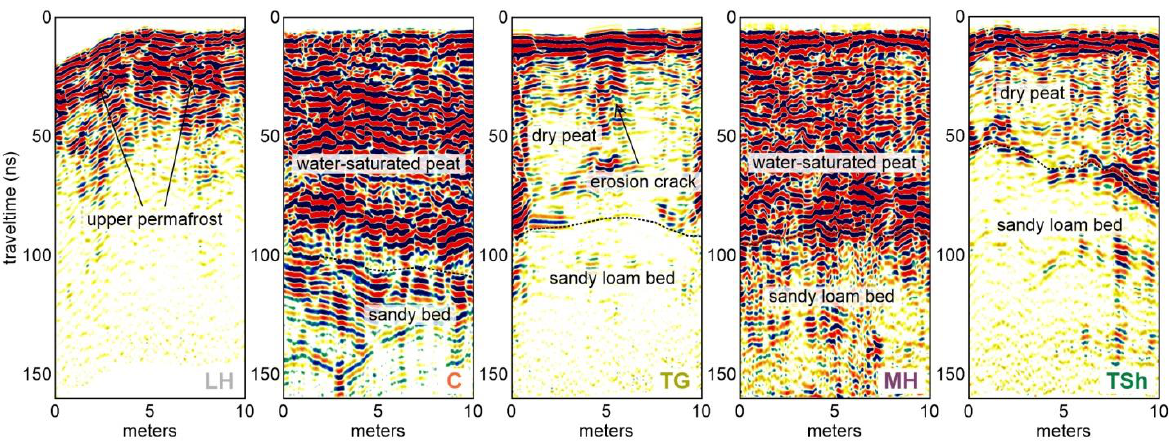
Figure 10. Fragments of GPR cross-sections illustrating GPR patterns under surfaces with different LCCs (NB algorithm).